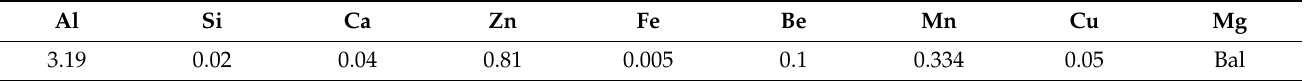
Table 1. Chemical composition (in wt.%) of AZ31B. Figure 1. Image of AZ31B showing microstructure after treatment with 4% nital.